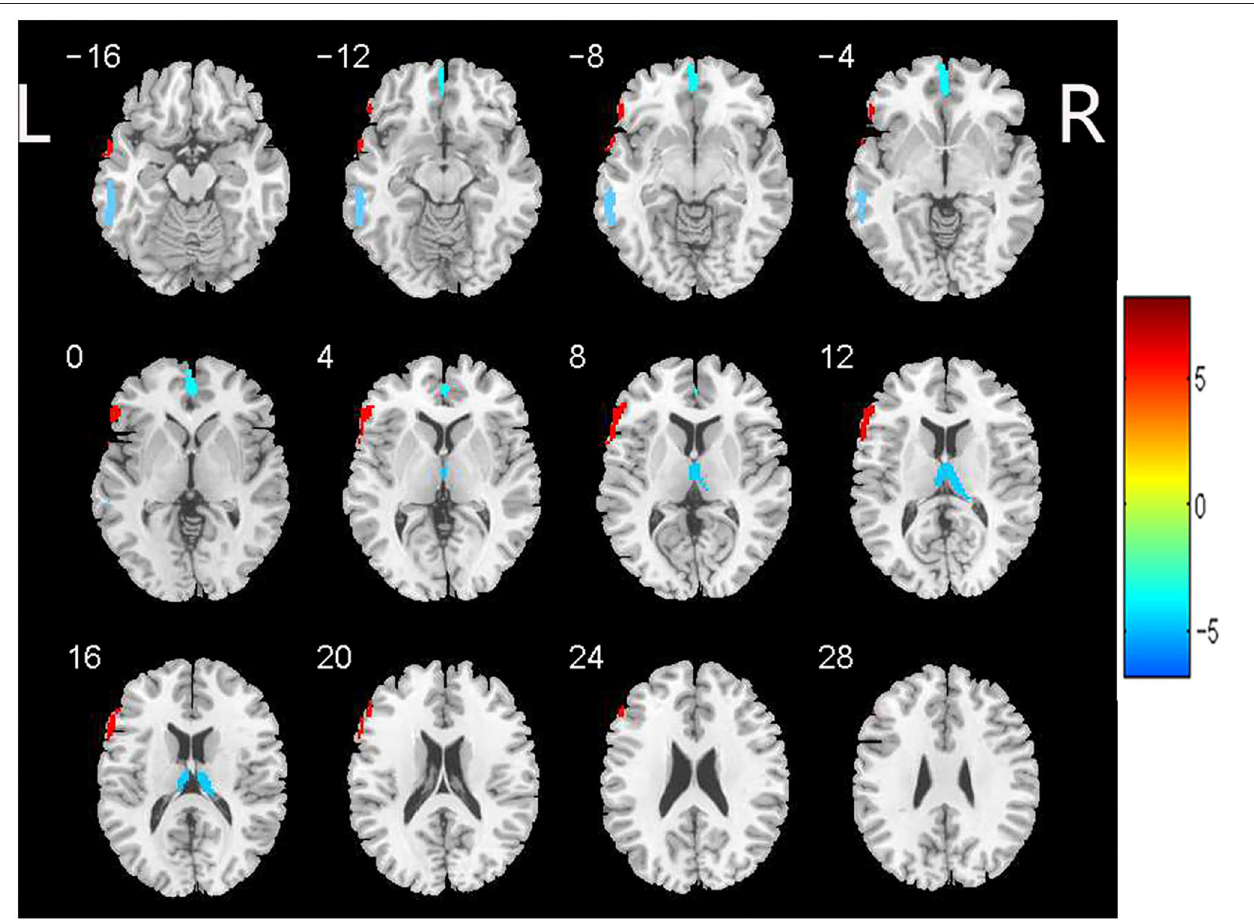
FIGURE 1 | Brain regions with significant differences in CBF between patients with WMHs and HCs. Significant decreased CBF in the left orbital medial frontal gyrus [MFG.L (orbital part)], left middle temporal gyrus (MTG.L) and right thalamus (Tha.R) was observed in the patients with WMHs relative to the HCs. While increased CBF was found in the left triangular inferior frontal gyrus [IFG.L (triangular part)] in WMHs group compared to the HCs. These regions were selected as regions of interest. The color bar indicates the T score. CBF, cerebral blood flow; WMHs, white matter hyperintensities; HCs, healthy controls.